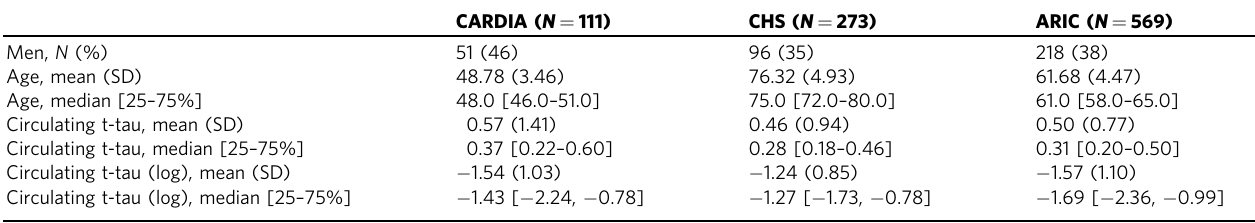
Table 2 Description of the African American participants included in the meta-analysis of circulating total-tau levels.